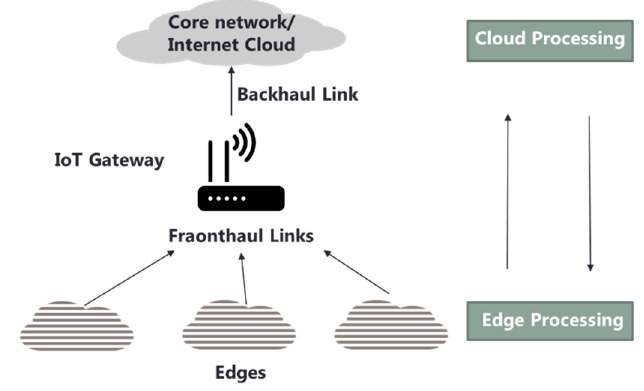
Figure 1. Generalized system model of collaborative edge-cloud processing.